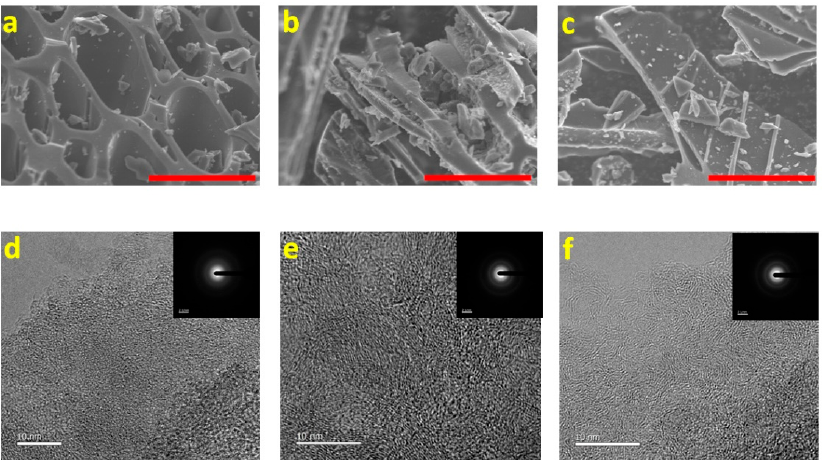
Figure 2. Morphologies of HC obtained at different temperatures observed by scanning electron microscope (SEM) (scale bar: 10 μ m): ( a ) HC-1000; ( b ) HC-1200; and ( c ) HC-1400. TEM images and SAED patterns of ( d ) HC-1000; ( e ) HC-1000; and ( f ) HC-1400.